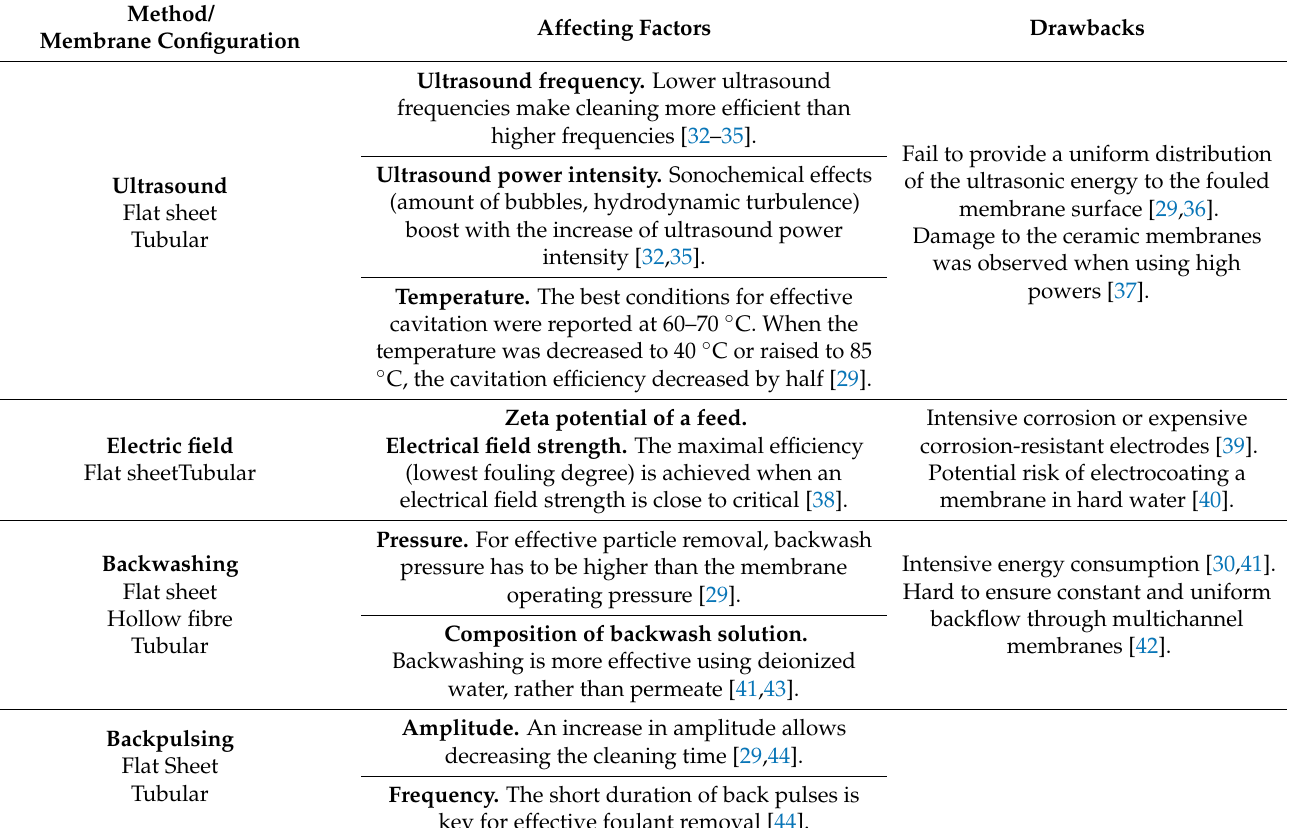
Table 1. Factors affecting the efficiency of non-reagent membrane cleaning